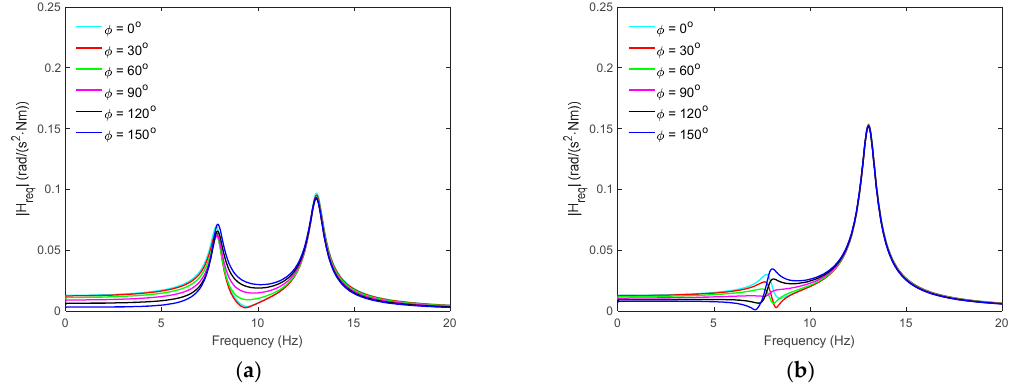
Figure 6. Examples of magnitude plots of H req ( j ω ) with constant p (50% in the left subplot and 80% in the right subplot) and di ff erent phase shifts φ between the front and rear motor torque demands, at 20 km / h, for L4 (2-speed 4WD): ( a ) Second gear on front axle, first gear on rear axle; ( b ) Second gear on front and rear axles.